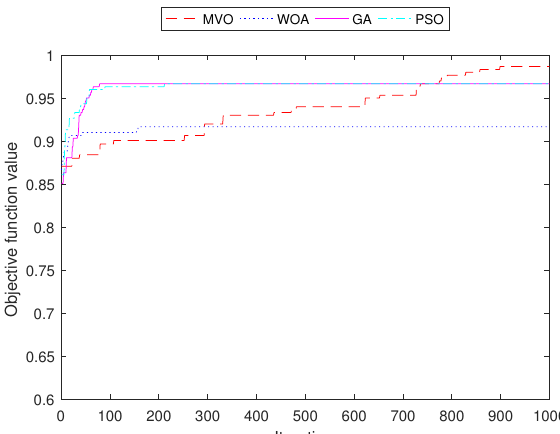
Figure 11. Performance comparison of the objective function value for INS-1 with 40 mesh